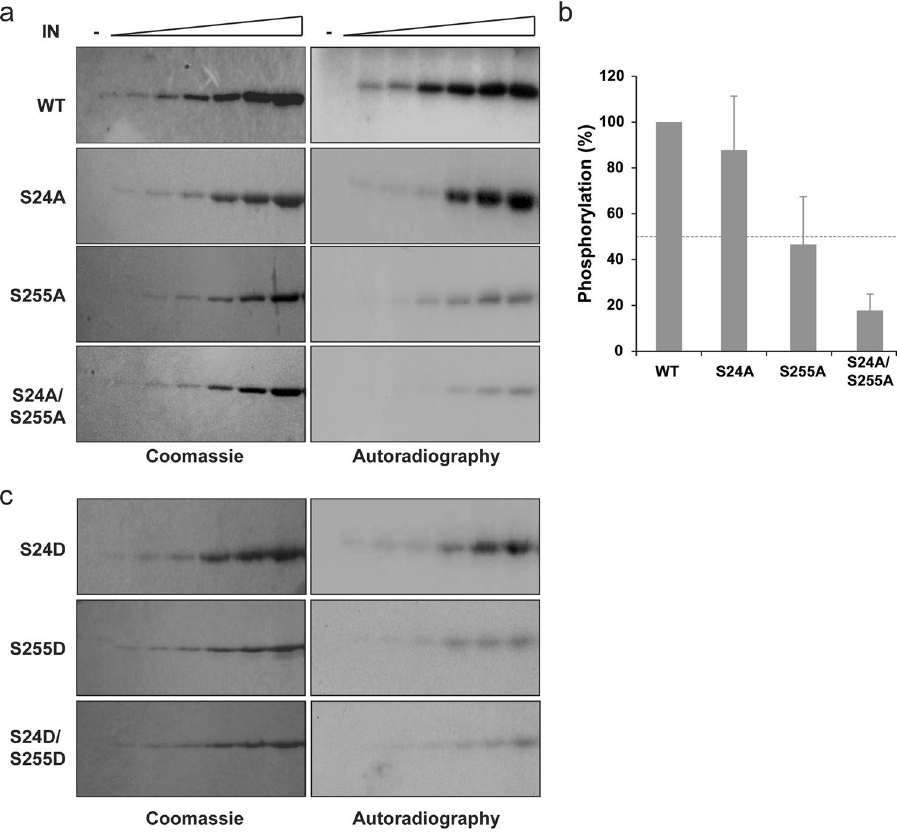
Figure 3. Phosphorylation of phosphomutant INs. Phosphorylation of recombinant WT IN compared to alanine ( a ) and aspartic acid ( c ) mutant. Increasing concentrations of IN (0, 100, 200, 400, 1000, 2000, 4000 nM) and 24 nM of GCN2 were used. Gels staining with Coomassie blue (left) and autoradiography (right). Quantification at the highest phosphorylation level for each protein ( b ). Mean and standard deviation derived from at least three independent experiments and were normalized to